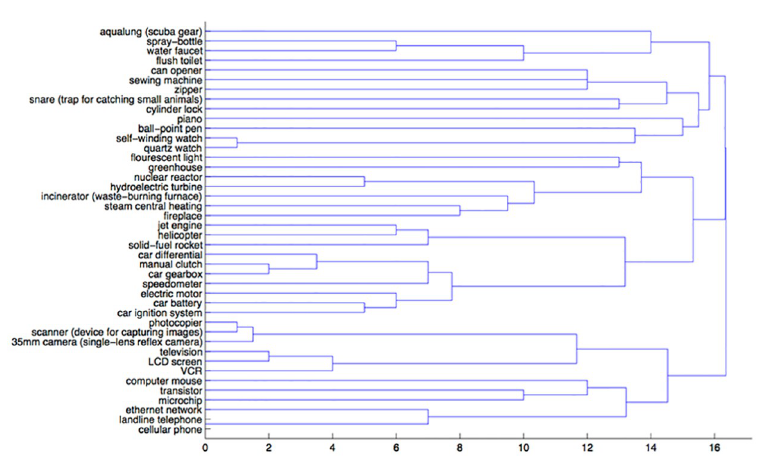
Fig 2. A dendrogram representing the function condition